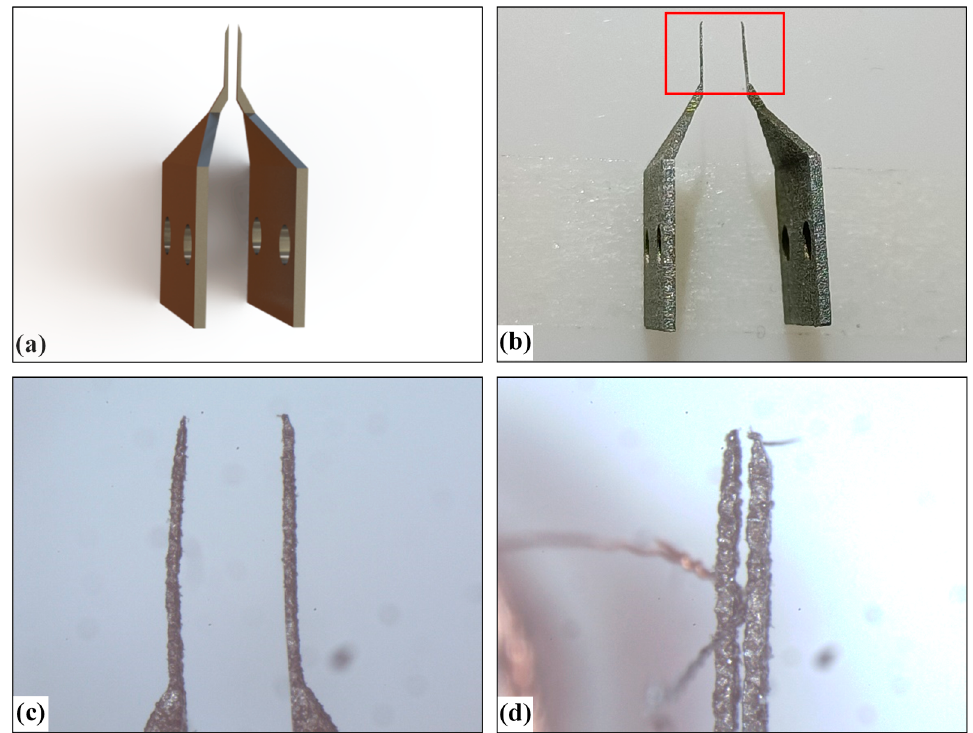
Figure 19. Direct-clamping-type micro-gripper made of iron: ( a ) 3D model of micro-gripper; ( b ) Picture of micro-gripper; ( c ) Picture of local micro-gripper’s tip corresponding to red box area in ( b ); ( d ) The status that micro-gripper captures a wire.